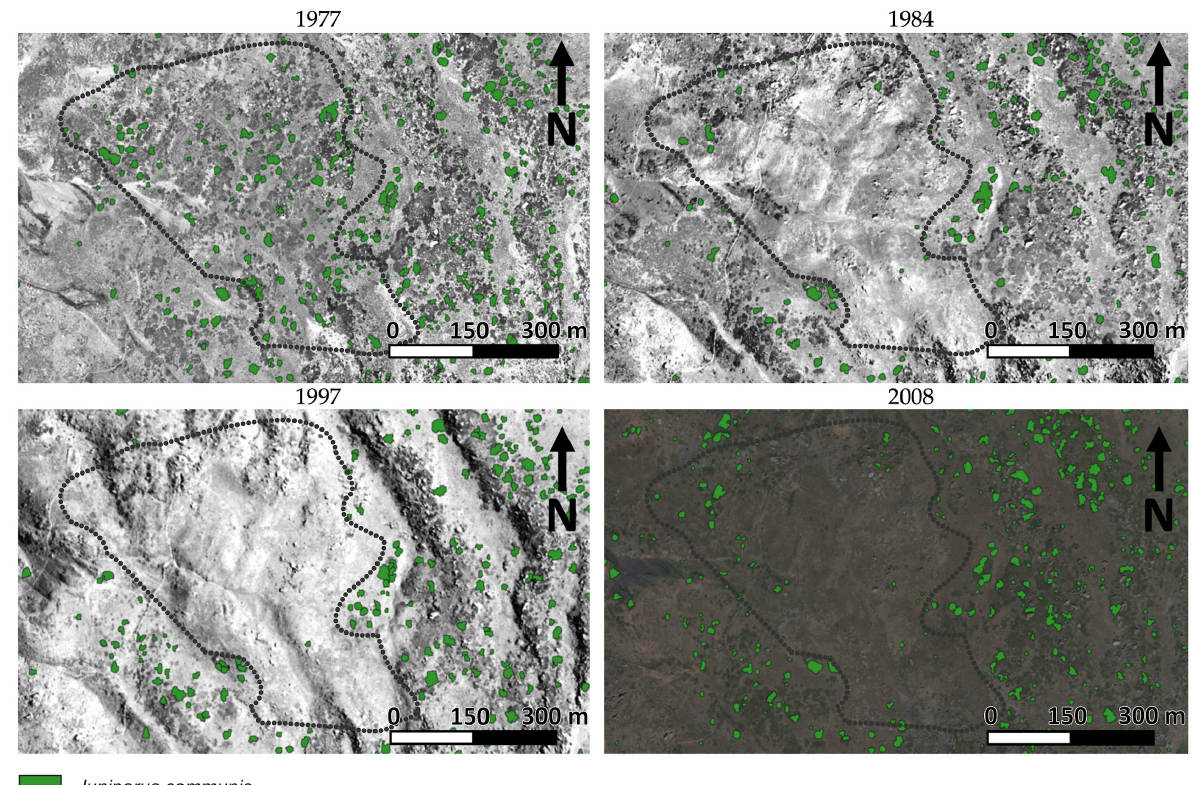
Figure 3. Detail of the mapping of Juniperus communis L. shrubs in Barranco de San Juan (Sierra Nevada, Spain) for the dates studied. The change in the size of the individuals over time can be seen, as well as the appearance or disappearance of some of the others. The area affected by the 1983 fire is seen mostly free of shrubs in the center (dotted-line polygon) of the 1984, 1997, and 2008 images.